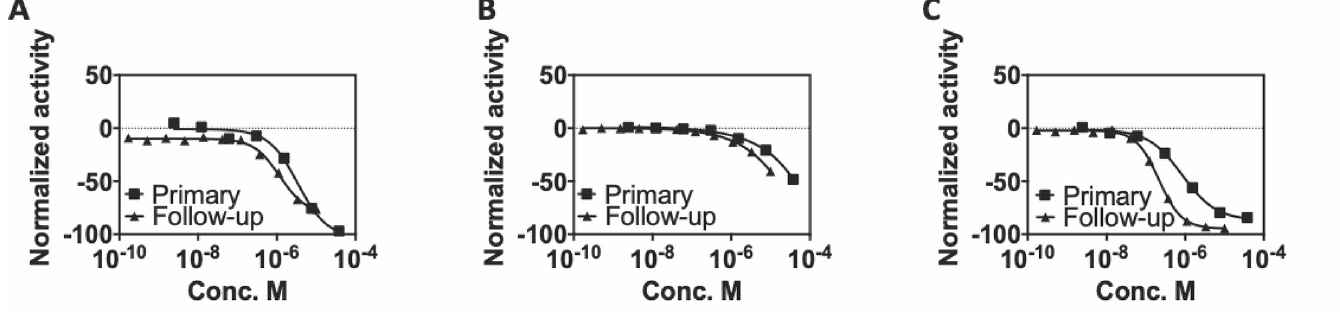
Fig 12. 6-Hydroxy-DL-Dopamine follow-up testing comparison to primary screening. Results shown for the (A) CisBio, (B) LANCE, and (C) AlphaScreen assays. Follow-up testing was conducted using freshly plated compound from powder stocks in an 11-point concentration response (n = 1).